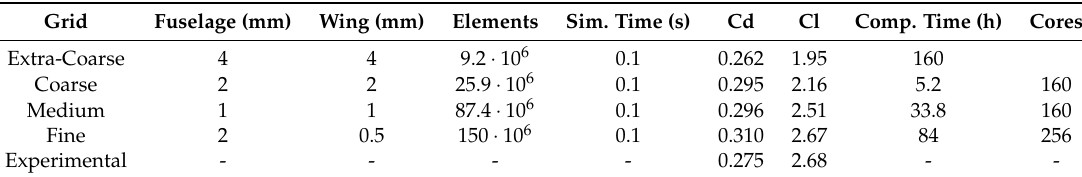
Table 3. Grid independence at 16